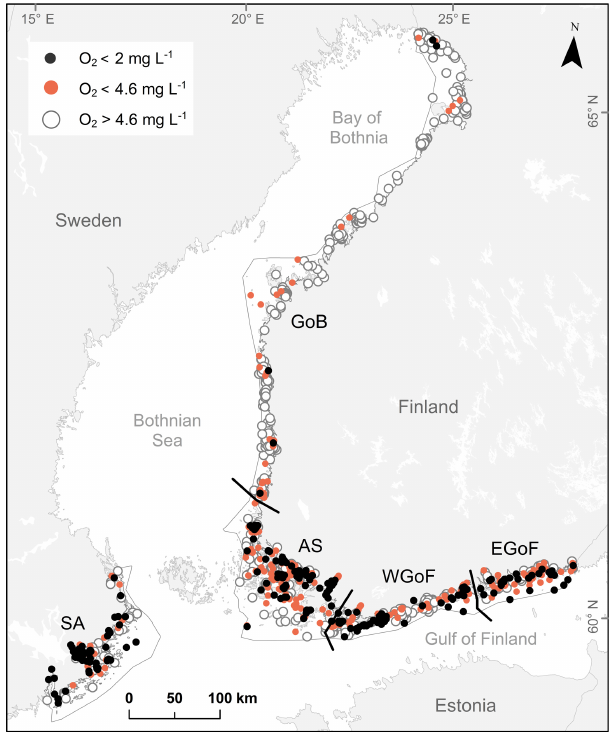
Figure 1. Study areas in Finland: AS – Archipelago Sea, WGoF – western Gulf of Finland, EGoF – eastern Gulf of Finland, and GoB – Gulf of Bothnia. Study area in Swe- den: SA – Stockholm archipelago. Orange dots represent mod- erately hypoxic sites (O 2 <4.6mgL − 1 ), black dots severely hy- poxic sites (O 2 <2mgL − 1 ) and white circles denote sites with O 2 >4.6mgL − 1 . Gray and black lines illustrate boundaries of Wa- ter Framework Directive